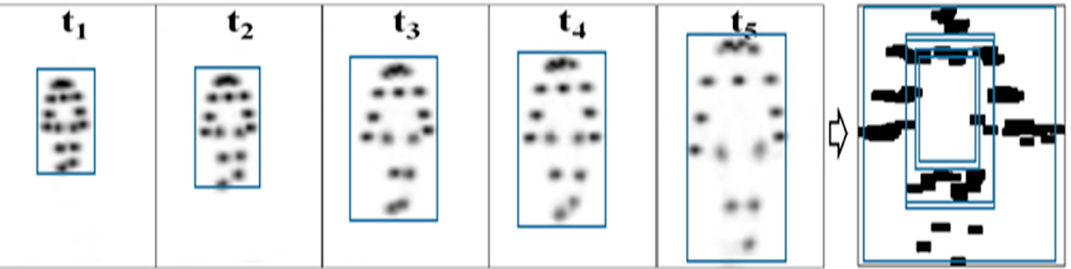
Figure 6. Iso-block postural identity (IPI) generated for a series of times and fusion of the IPI with a DJNP (right).